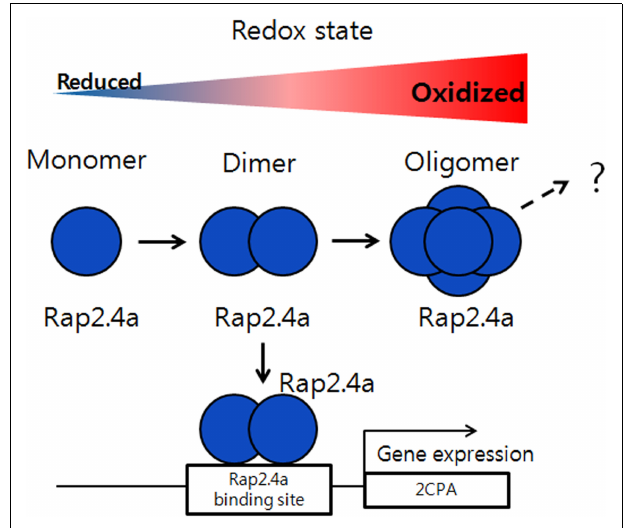
FIGURE 2 | Regulation of gene expression by Rap2.4a through redox changes. Under oxidizing conditions, Rap2.4a changes its structure from monomer, dimer to oligomer.The homodimeric structure of Rap2.4a can bind to the DNA promoter of antioxidant like 2-Cys peroxiredoxin and plays as transcription factor to regulate its gene expression. If the redox balance changes to more oxidized condition, the expression level of Rap2.4a is increased. But, during severe oxidative conditions, Rap2.4a expression is decreased and lost its transcriptional activity due to oligomerization.This model is modified from the reference of Shaikhali etal.